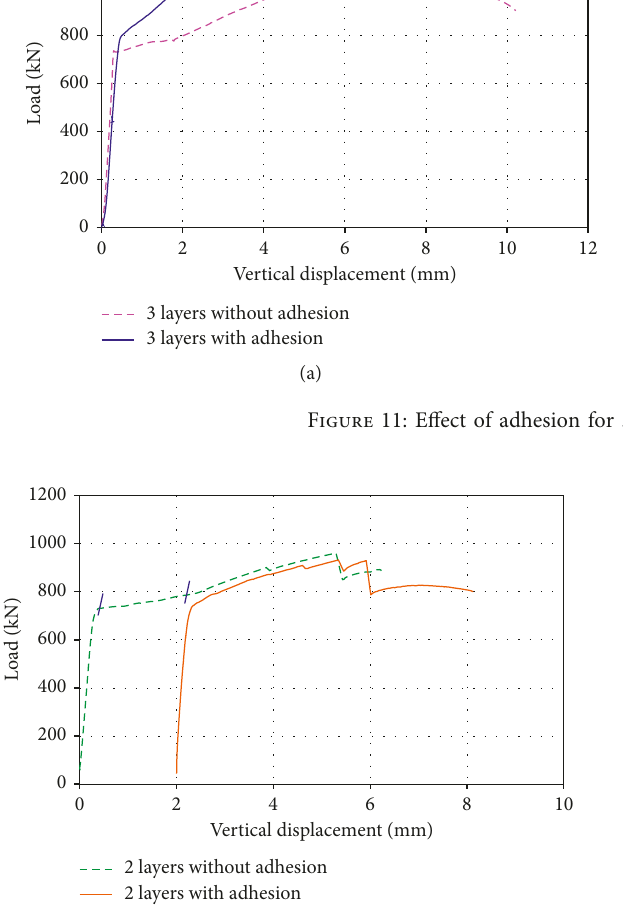
Figure 12: Adjustment of postcritical behavior—Series